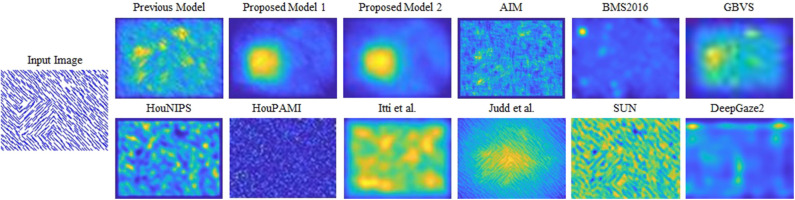
Saliency maps of the models compared in this study for a synthesized input image. The pattern-defined figure (a square) is in the lower-left of the input image. Neurophysiological data show that primate V1 neuron activity is enhanced when the receptive fields are within the figure. Different from previous proto-object model and other saliency models, our model can discriminate the pattern-defined figure from the background. The cited models: AIM (Bruce and Tsotsos, 2005), BMS2016 (Zhang and Sclaroff, 2016), GBVS (Harel et al., 2007), HouNIPS (Hou and Zhang, 2008), HouPAMI (Hou et al., 2012), Itti et al. originally from Itti et al. (1998) but we used the latest code from Harel et al. (2007), Judd et al. (2009), SUN (Zhang et al., 2008), and DeepGaze2 (Kümmerer et al., 2016).